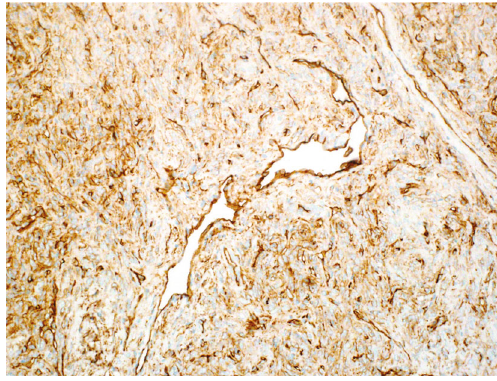
Figure 5: A di ff use positive immunoreactivity against CD34 ( × 20).